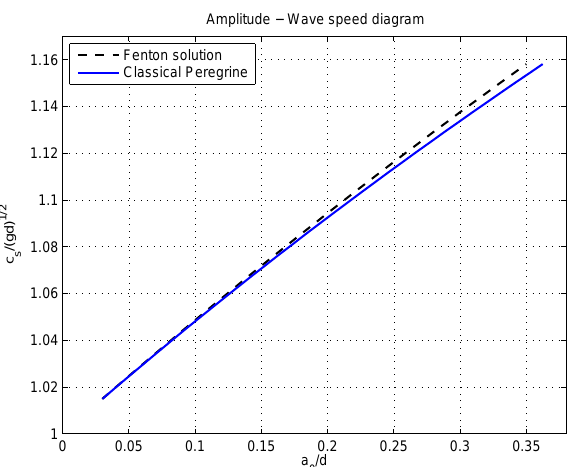
Fig. 7. Amplitude–speed relation of solitary wave solutions of Figure 7. Amplitude-speed relation of solitary wave solutions of (3.1) and of Eq. (5) and of Fenton’s ninth-order asymptotic approximation of Fenton’s ninth-order asymptotic approximation of solitary waves us- solitary waves using the Euler equations for the full water wave ing the Euler equations for the full water wave problem.